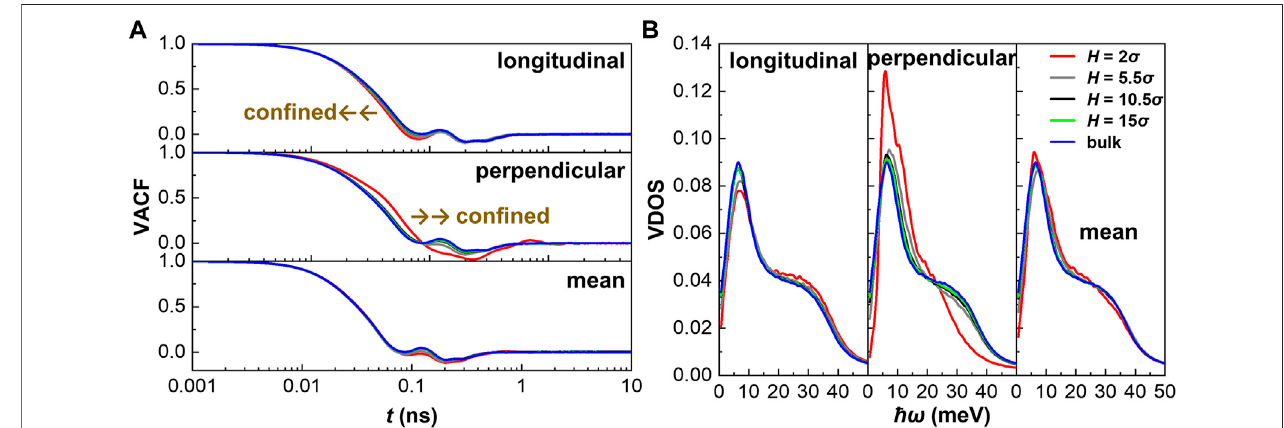
FIGURE 4 | VACF and VDOS of water molecules represented by oxygen